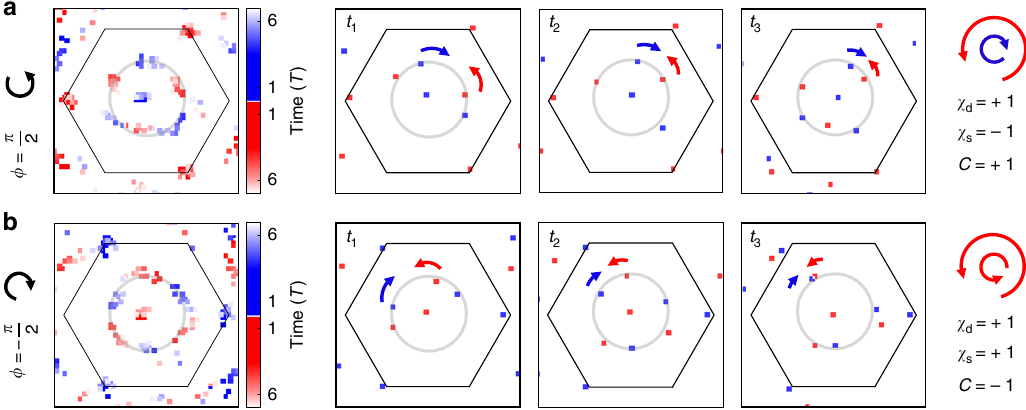
Fig. 9 Sign of the linking number. a Vortex data in the non-trivial regime (shaking phase of π /2 and shaking detuning of δ /2 π = − 372 Hz). The fi rst sub fi gure shows the time-integrated data, while the other sub fi gures show successive stroboscopic time steps t 1 = 13 ⋅ T /4, t 2 = 17 ⋅ T /4, t 3 = 21 ⋅ T /4 after the quench, where T is the driving period. The arrows mark the direction of motion of the respective vortices. The vortex contour has a positive chirality, while the enclosed static vortex has a negative chirality, revealing the Chern number + 1 (see text). b , Reverse shaking (gray point in Fig. 3) for δ /2 π = − 359 Hz and for time steps t = 14 ⋅ T /4, t = 18 ⋅ T /4, t = 22 ⋅ T /4 after the quench. The chirality of the enclosed vortex is now inverted and the 1 2 3 Chern number is −